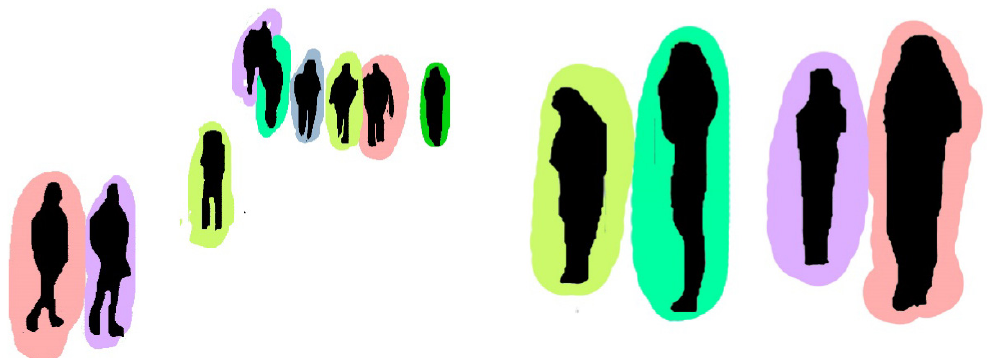
Figure 5. Gaussian smoothing results over given human-verified data.